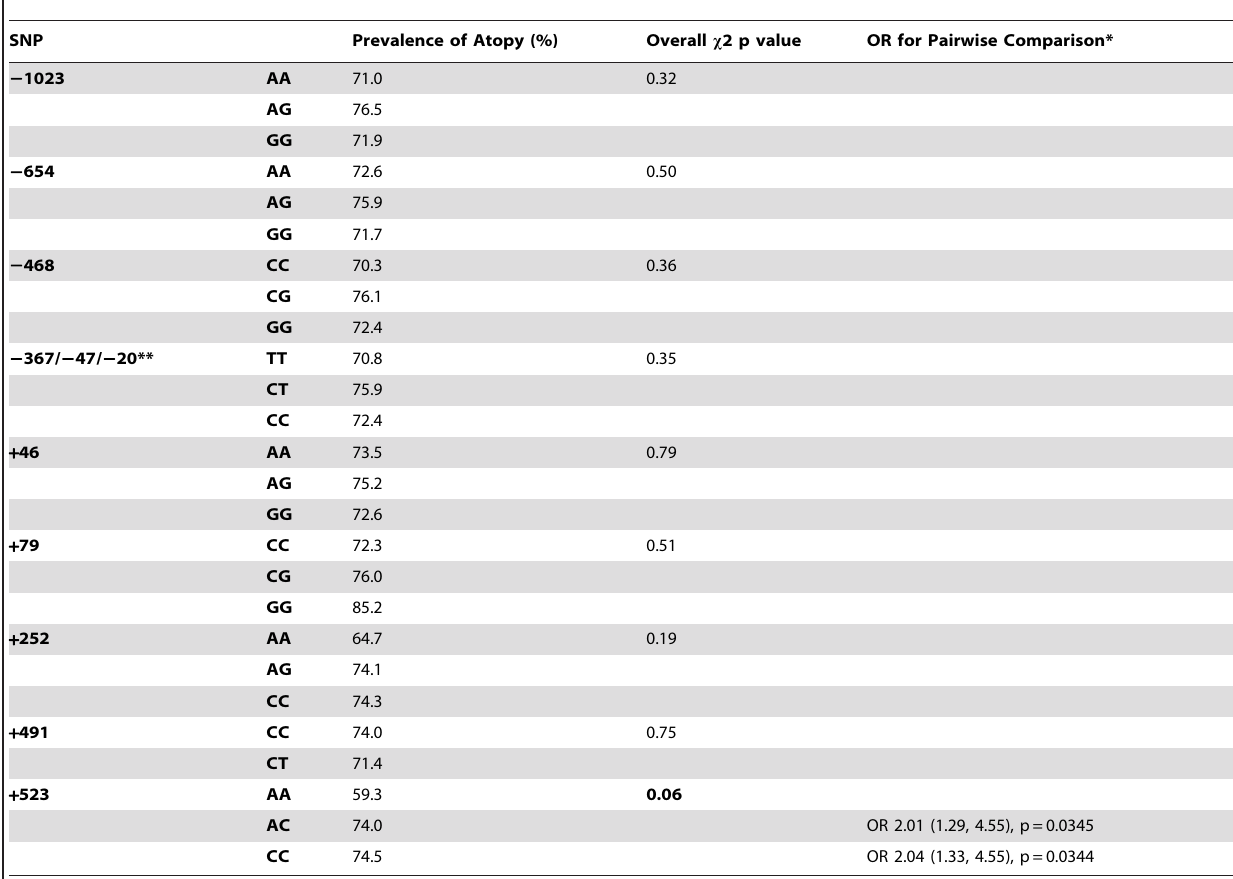
Table 6. ADR b 2 + 523 Genotypes are Associated with Atopy (n=2979).